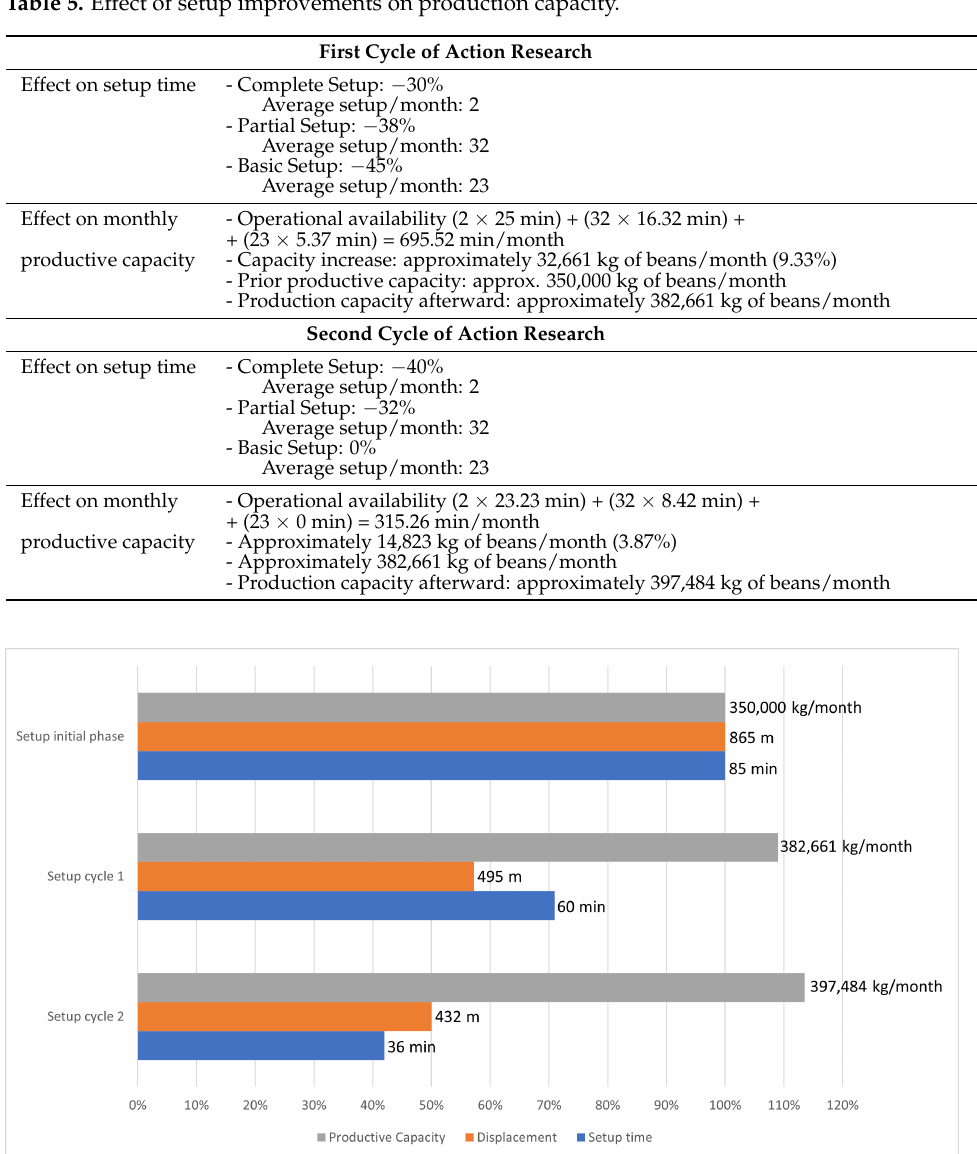
Table 5. Effect of setup improvements on production capacity.